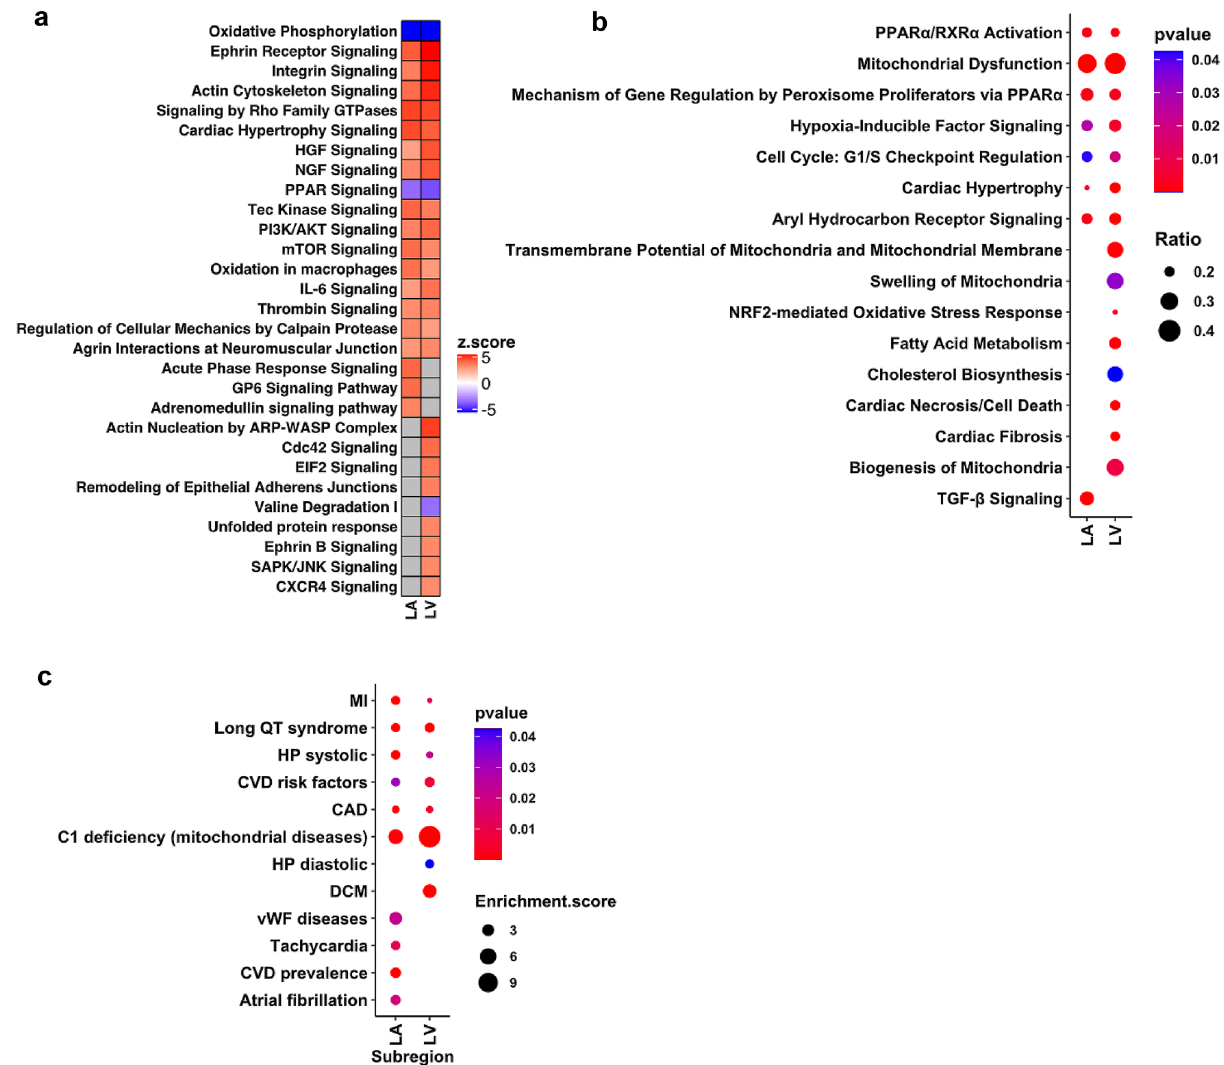
Figure 6. HFrEF heart displayed shared and distinct signaling pathways and disease associations. ( a ) Heatmap shows significantly overrepresented canonical pathways in HFrEF LA and LV by IPA on HFrEF DEGs ( b ) Dot plot represents enriched clinical pathology and pharmacological toxicity lists in the LA and LV by IPA on HFrEF DEGs. The size of the dot reflects the Ratio (the number of HFrEF DEGs that maps to the tox list divided by the total number of genes that map to the same tox list) and the color of the dot indicates increasing significance of the enriched pathways from blue to red. ( c ) Significantly enriched GWAS archived cardiovascular diseases represented by DEGs in HFrEF-diseased hearts. The size of the dot reflects the Enrichment score (the odds that the GWAS trait is over-represented among genes of interests vs. the odds among all other genes) and the color of the dot indicates increasing significance of the enriched GWAS trait from blue to red. Significantly enriched terms are presented and significance is indicated as p <